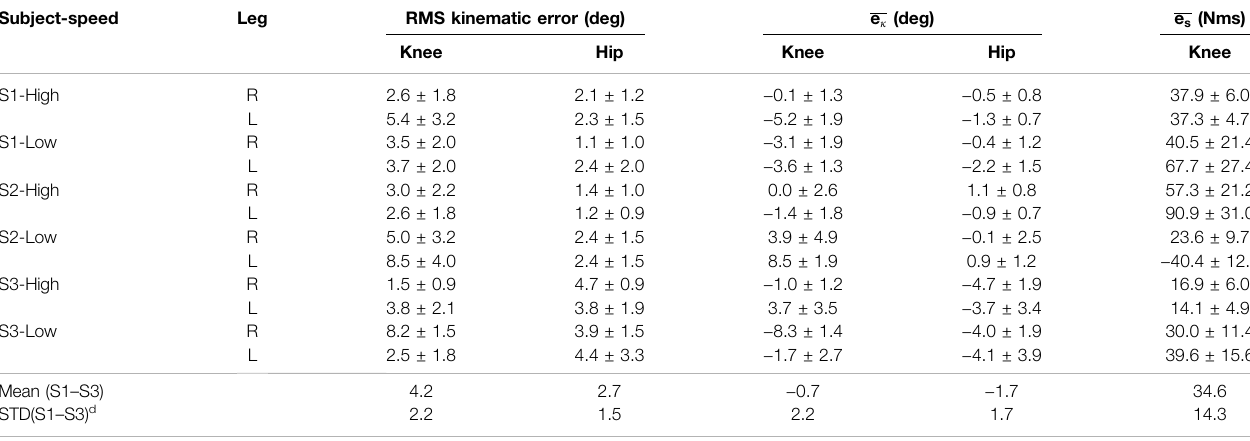
TABLE 2 | Tracking results for each participant at high (0.8 mph) and low (0.5 mph) treadmill walking speeds a : RMS kinematic tracking error (moving window in seconds to complete a gait cycle) b , average of kinematic tracking error e κ , and average of stiffness tracking error e sc